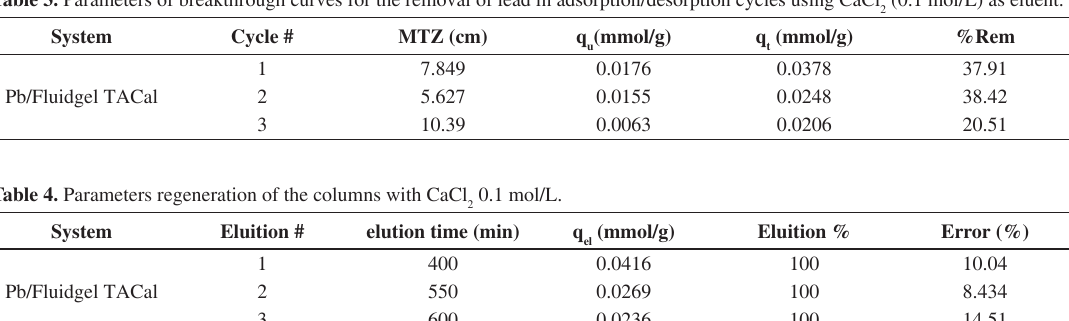
(0.1 mol/L) as eluent. 2